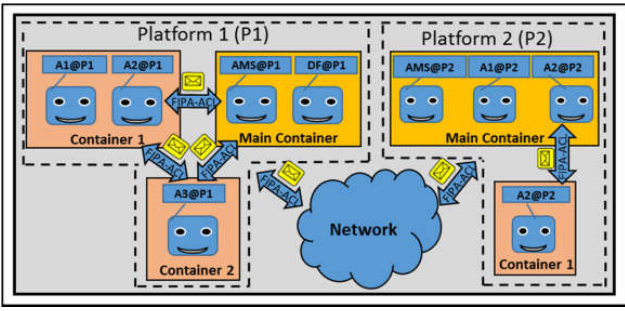
Figure 2. Java Agent Development (JADE).